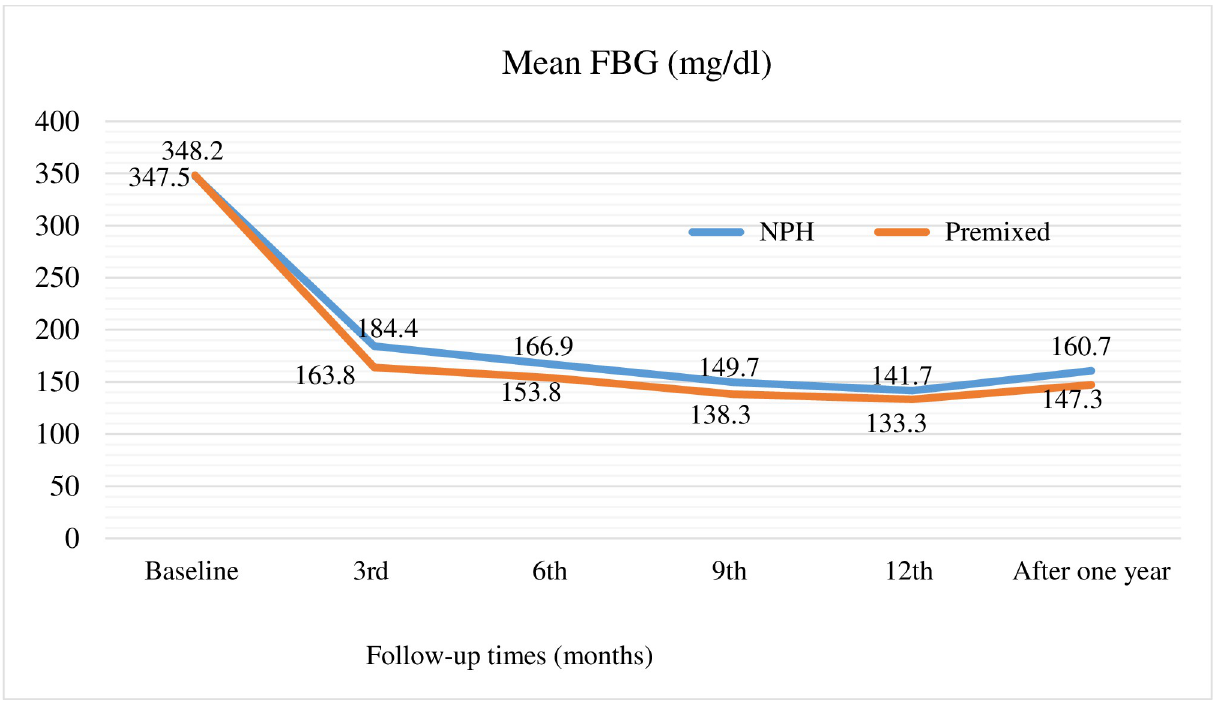
Fig 1. Blood glucose levels during a one-year follow-up period of inulin (NPH vs premixed) initiation.